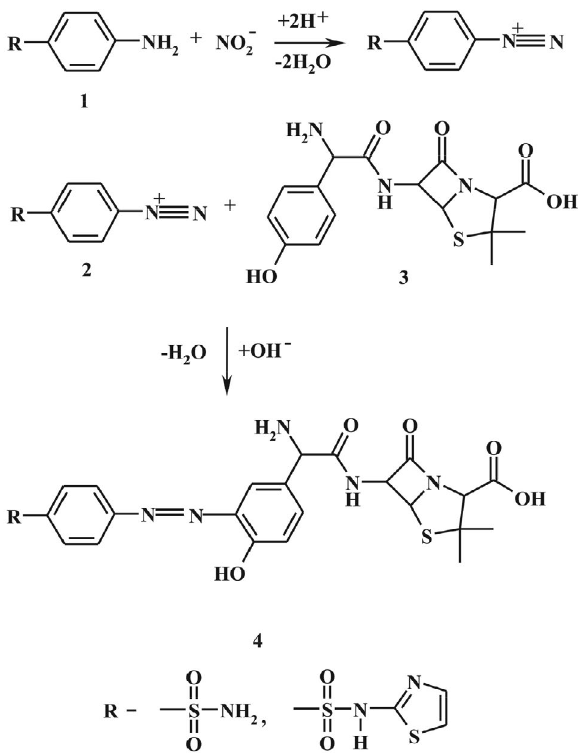
Scheme 1. Scheme of amoxicillin interaction with sulphanilamide and